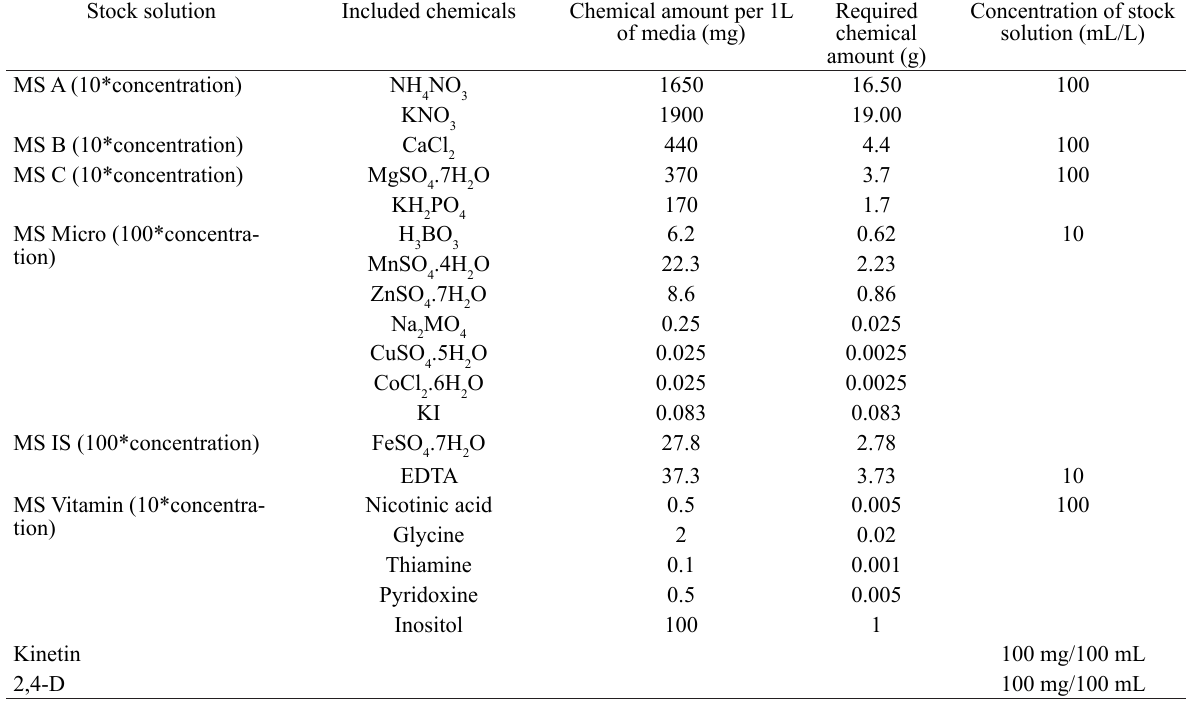
Table 1: Required chemical amounts needed to prepare one liter stock solutions of MS media and concentrations of the stock solutions .